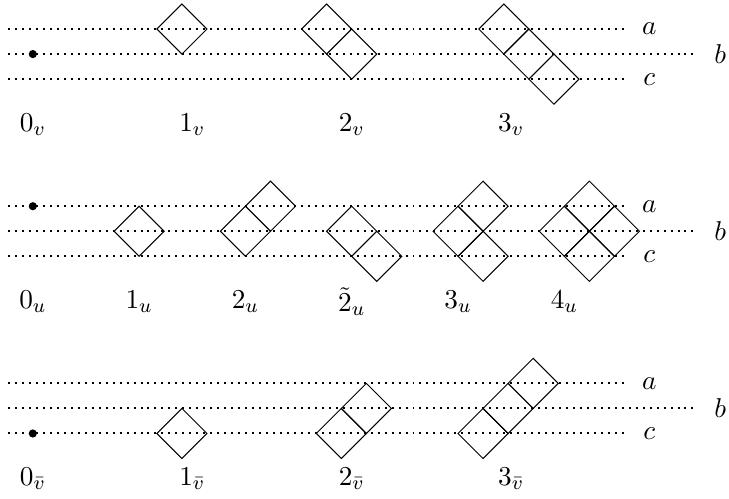
Figure 7 . The list of diagrams if one has fermions antifermions and scalars. The diagrams are labeled by 0 , . . . , 3 , 0 , . . . , 4 , 0 3 , where the indicate coincides with the number of boxes v v u u ¯ v , . . . , ¯ v in a diagram and the indices v , u and ¯ v tell weather a diagram is connected to fermions scalars or antifermions. As before three dotted lines correspond to the spaces a , b , c